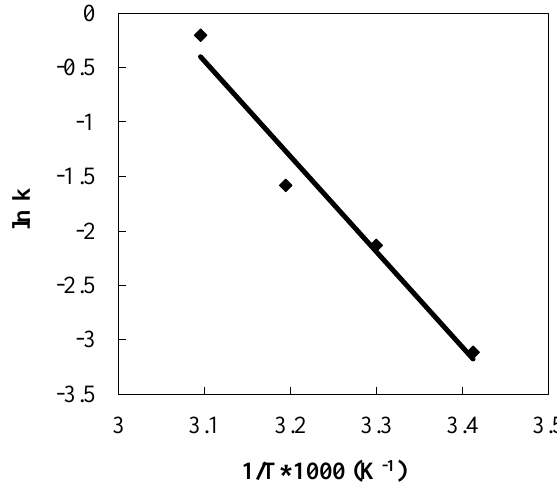
Figure 24. Arrhenius plots for the pseudo-first-order rate constants for CPT gel where the straight line is expressed by the linear equation, Y = −8.57 x + 26.7, with the correlation factor ( R 2 ) = 0.9671 [33] (with permission for reuse from Elsevier B.V.).